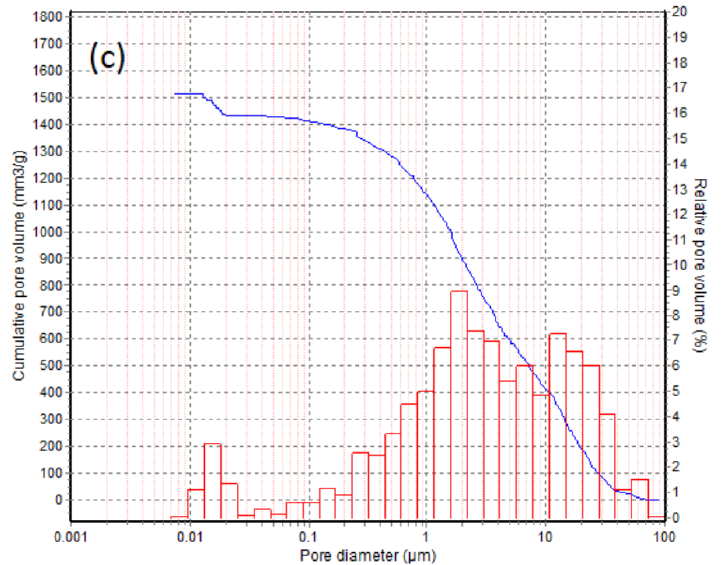
Figure 5. Cumulative volume distribution of pores by MIP in the adsorbent samples based on straw biomass ash with nano-structural additives: ( a ) S-UPS; ( b ) HalRaw4; and ( c ) Kao4. The true density ( ρ ) and the specific surface area (SSA) of the adsorbent samples, based on straw biomass ash, are reported in Table 3. As can be seen, although the true density is very similar for all samples (2.42–2.54 g/cm 3 ), the comparison turns out to be largely favorable for those containing halloysite (HalRaw4) and kaolinite (Kao4), with an SSA value around 5-fold higher than that of raw straw ash (S-UPS). This result is congruent with the the larger the SSA. Table 3. True density and specific surface area (SSA) of the obtained adsorbent samples based on straw biomass ash with nano-structural additives: S-UPS; HalRaw4; and Kao4.